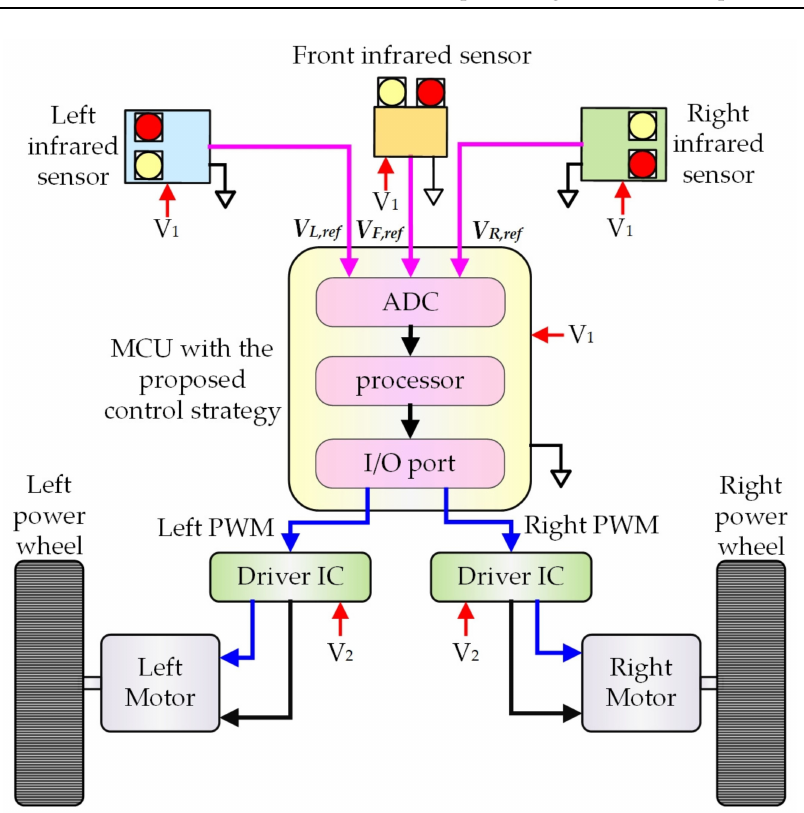
Figure 2. Schematic diagram of the control system structure of the self-driving electric mobile robot. Figure 3 shows the arrangement of various components of the self-driving electric mobile robot. Figure 3a is the top view of the self-driving electric mobile robot, showing the arrangement of three infrared sensors, two power wheels, a battery module, and a DC/DC converter. The MCU of the self-driving electric mobile robot is also illustrated. Figure 3b is the left view of the self-driving electric mobile robot. The positions of two infrared sensors, a battery module, two DC/DC converters, the left motor, the left power wheel, the universal wheel, and the MCU of the self-driving electric mobile robot can be observed. The 5 V output supplies of two DC/DC converters are V 1 and V 2 , supplying power to various components, as shown in Figure